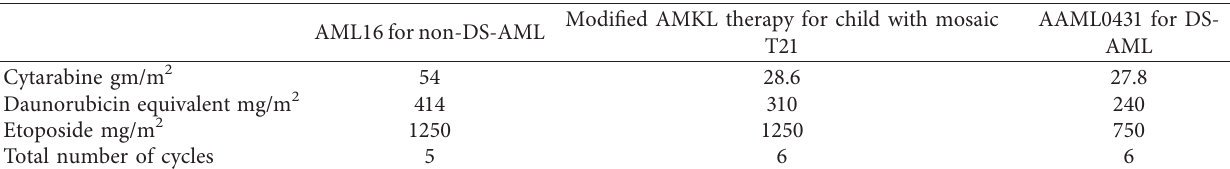
Table 1: Comparison of modified therapy for child with mosaic T21 with AML16 (NCT03164057) for non-DS-AML and AAML0431 (NCT00369317) for